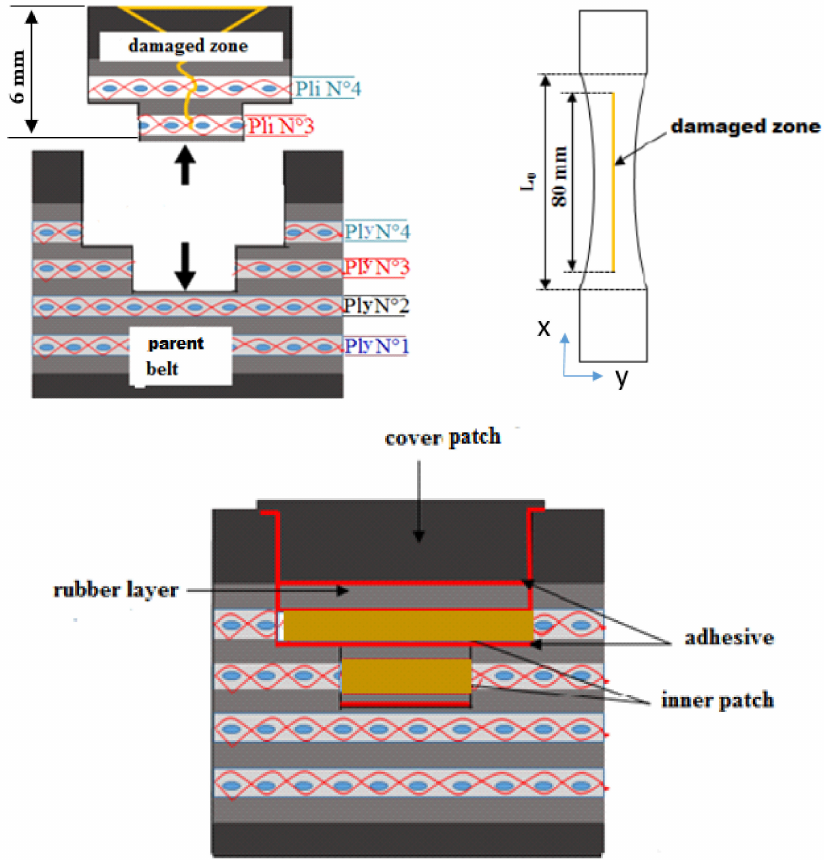
Figure 5. Diagram of the bonded belt patch repair technology specimen.